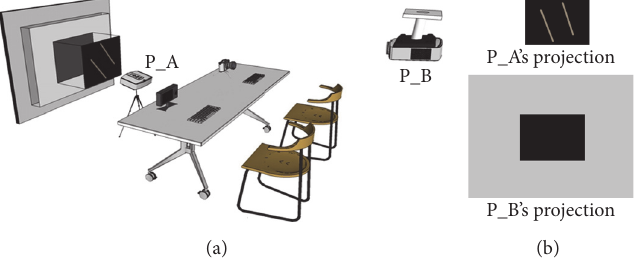
Figure 1: Experimental environment. (a) The layout of participants room. (b) The projection of P A and P